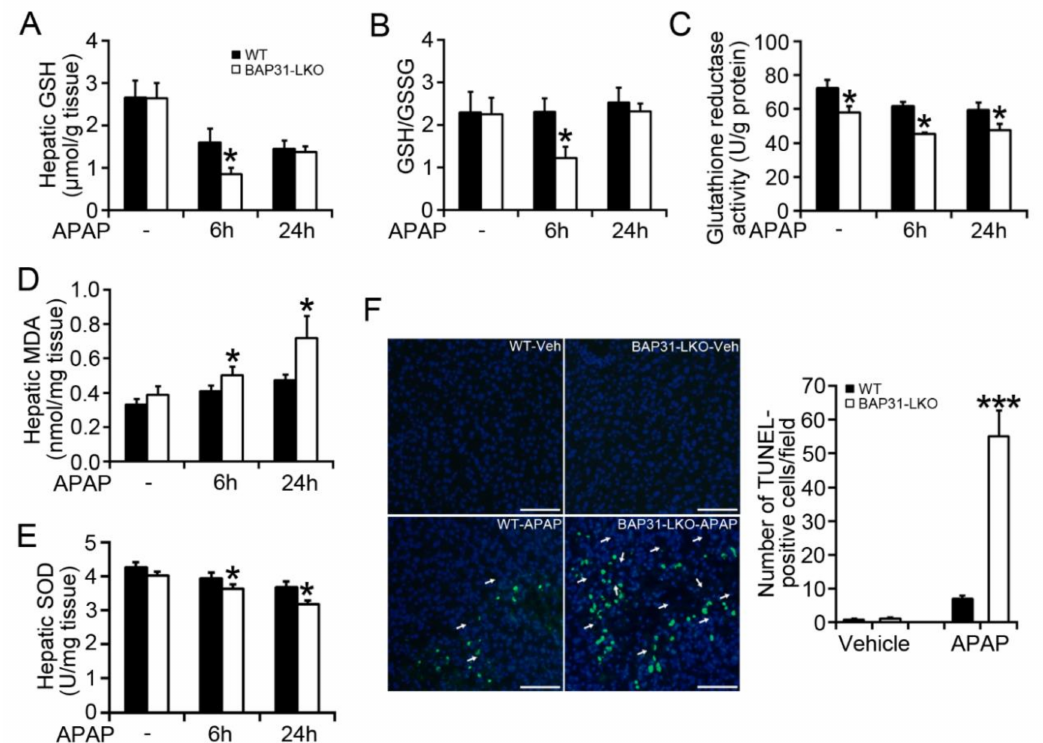
Figure 2. BAP31-deficiency amplified APAP-induced GSH depletion and hepatotoxicity. ( A ) Hepatic GSH, ( B ) GSH/GSSG ratio, ( C ) glutathione reductase activity, ( D ) hepatic MDA, and ( E ) hepatic SOD were determined in each group of mice. n = 5–7 per group. ( F ) Representative images of TUNEL staining in each group of mice 24 h post APAP injection (left panel). Arrows indicate the apoptotic hepatocytes (green staining). Nuclei were counterstained with DAPI (blue). Semi-quantification of the number of TUNEL-positive cells per field (right panel). Scar bar = 100 µ m. n = 4 per group. Data are expressed as mean ± SE. *, p < 0.05, ***, p < 0.001, BAP31-LKO compared to WT